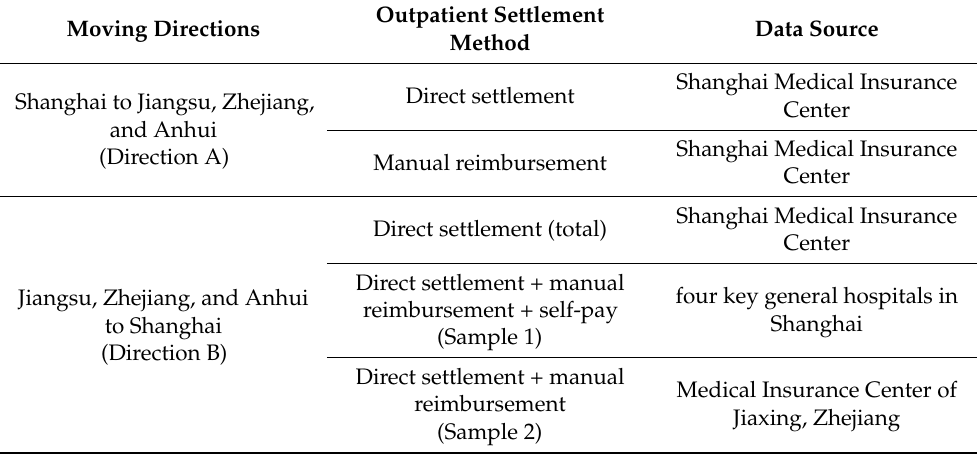
Table 1. Trans-provincial outpatient volume data source.